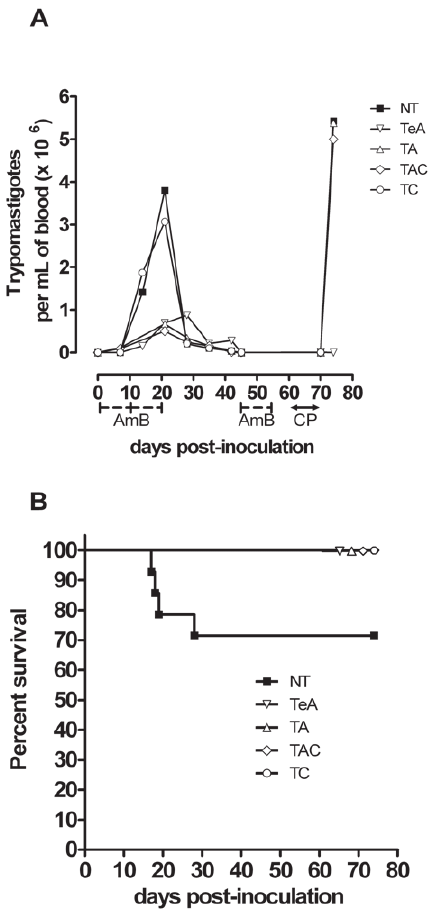
Figure 1. Survival and course of T.cruzi infection in AmBisome - treated BALB/c mice. BALB/c mice were i.p. inoculated with 1,000 blood trypomastigotes. NT: untreated mice; AmBisome was administred either in early acute phase (TeA), in acute phase (TA), or in chronic phase (TC). TAC mice treated by AmBisome during the acute and the chronic phases of infection. (A) Parasitaemia determined by fresh blood microscopic examination. AmB: AmBisome administration period, CP: cyclophosphamide administration period. (B) Survival curve of T. cruzi - infected mice.